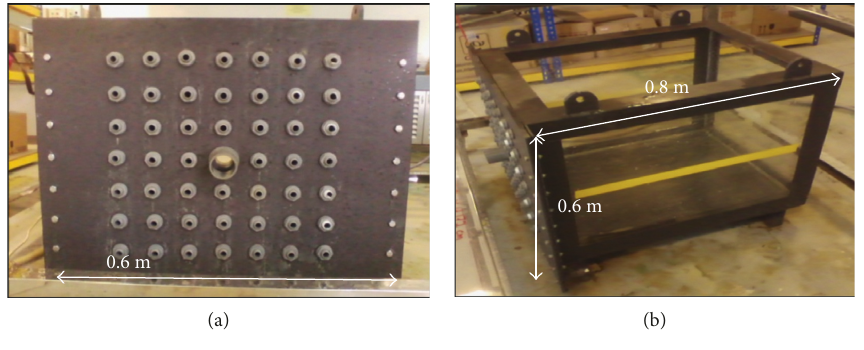
Figure 4: Model box. (a) Front view and (b) isometric view.